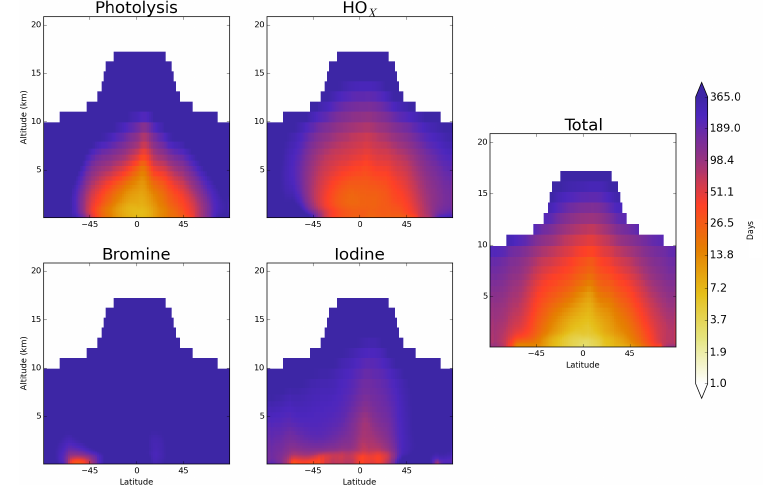
Figure 14. Global annual O 3 mean zonal chemical lifetime for different O X loss routes (Photolysis, HO X , Iodine, Bromine, and Total) in the “Br + I” simulation. Values are shown on a log